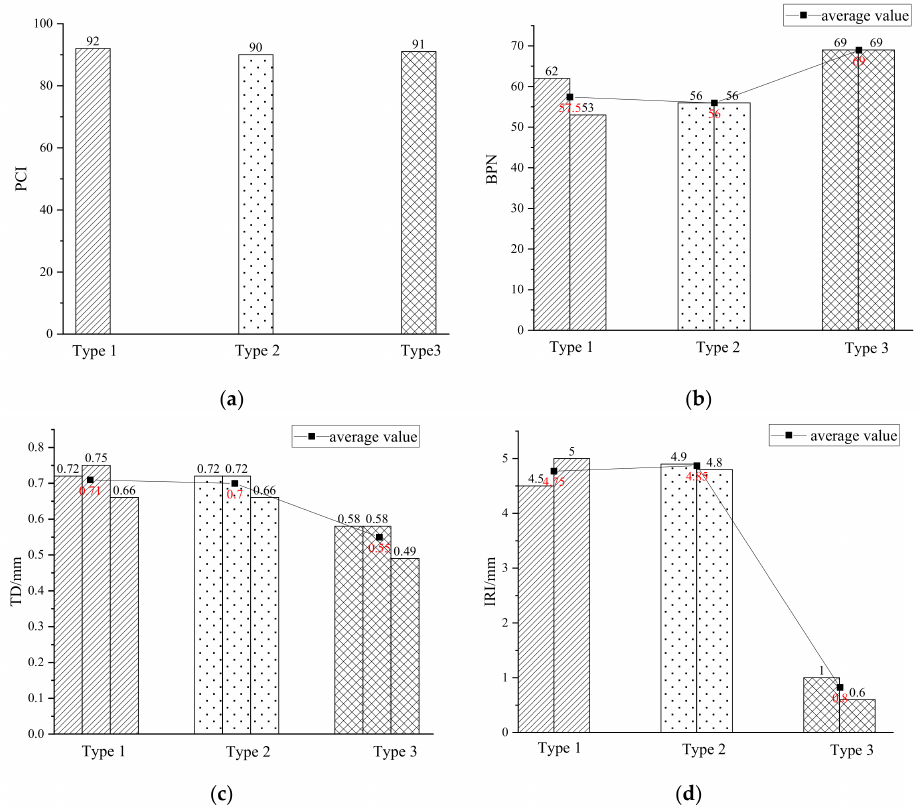
Figure 6. Field test data of the three VTAOs. ( a ) PCI; ( b ) BPN; ( c ) TD; ( d ) IRI.